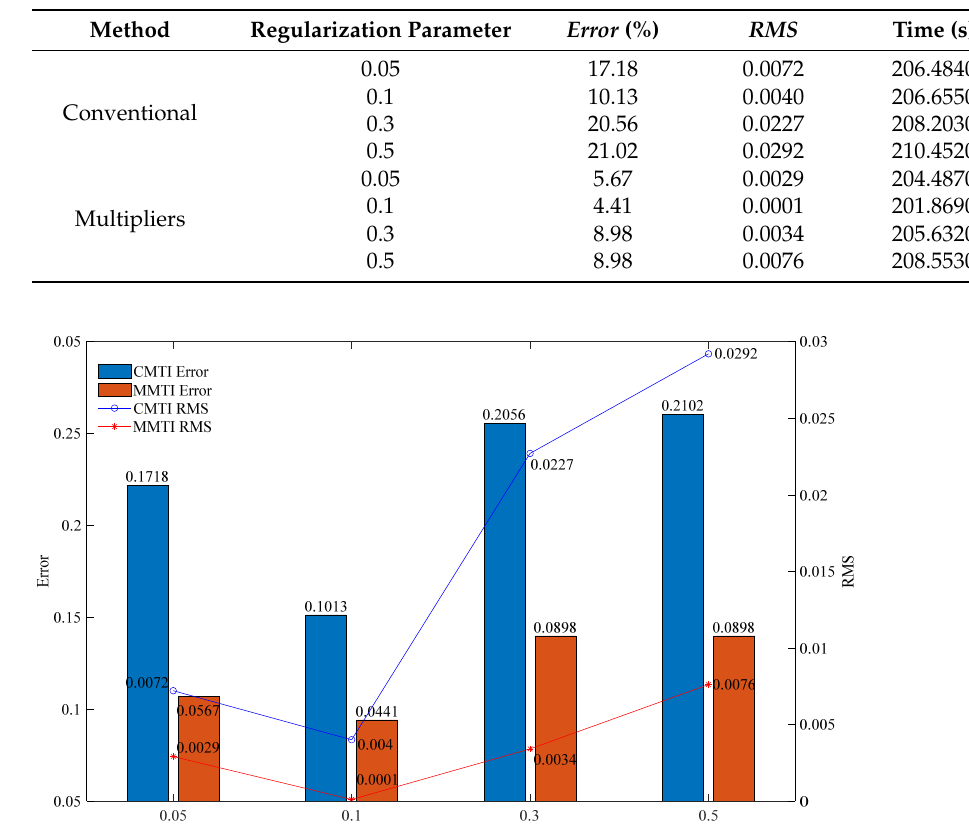
Figure 9. Comparison of RMS data fitting and model errors for different regularization factors.